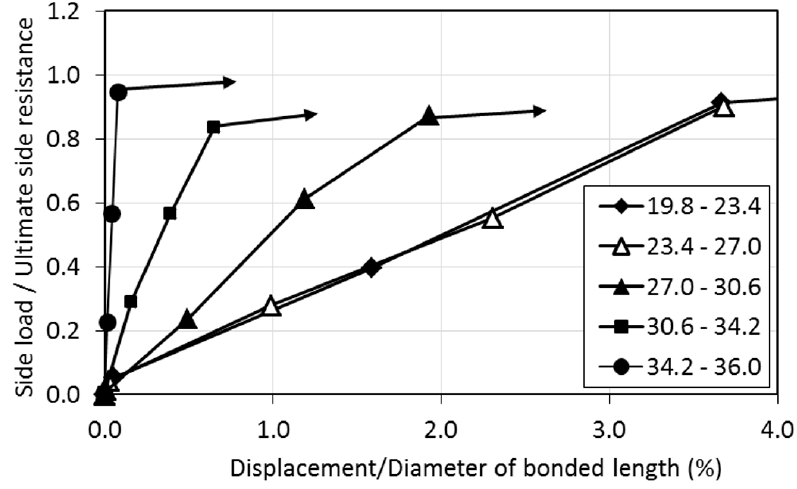
Figure 8. Transfer curves of side resistance for 5 segments of the bonded length of anchor T1.